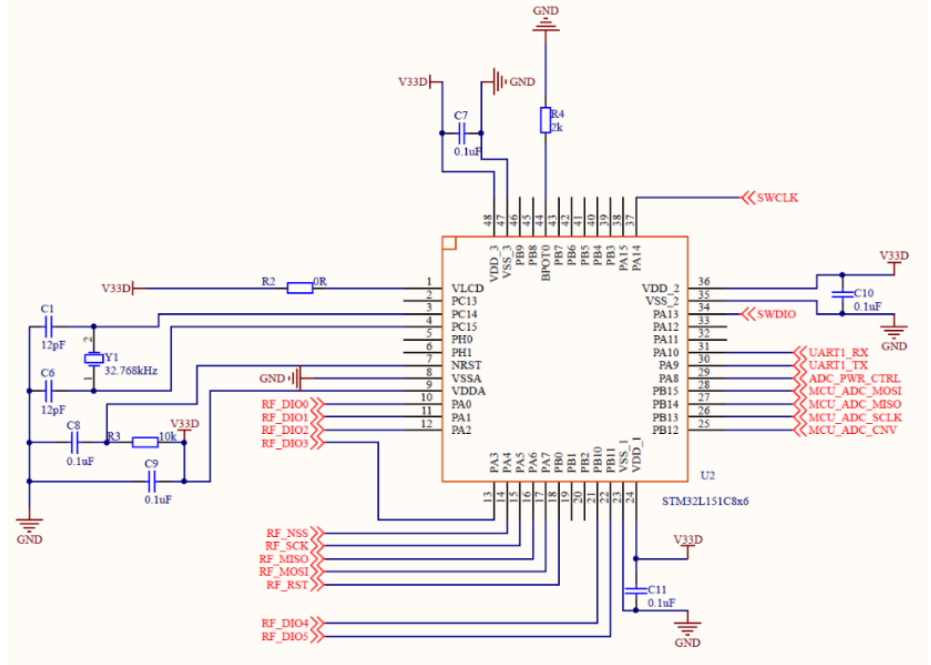
Figure 4. The circuit diagram of STM32L151C8X6.